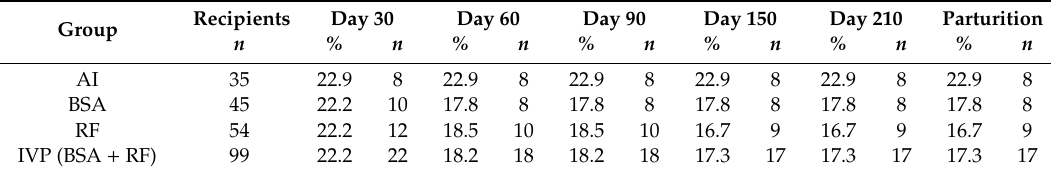
Percentages are means and n are number of animals.